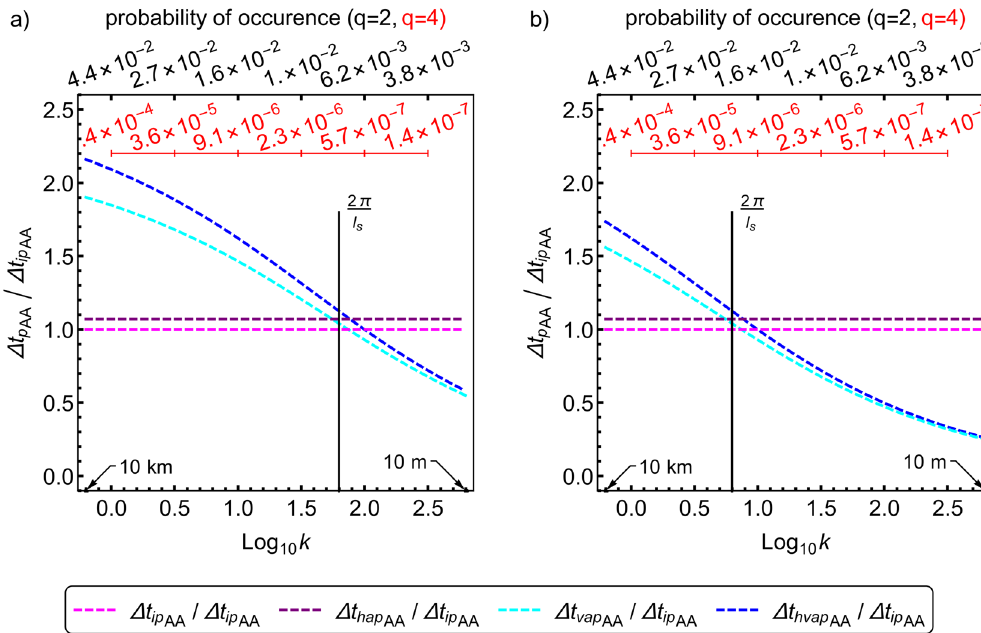
Figure 5. Ratio of the angular averaged theoretical predictability limits of anisotropic horizontal wind fields to that of isotropic horizontal wind fields. The wind fields have multifractal parameters α = . = . = . C H 1 5, 0 15, 0 33, and anisotropy parameters, as discussed in the text. The two panels differ only 1 by the sphero-scale l s . The subscripts ip , hap , vap , hvap denote isotropic, horizontally anisotropic, vertically anisotropic, horizontally and vertically anisotropic cases, whereas the subscript AA indicates angular averaging. The wavenumber k = | k | is in km − 1 and corresponds to scales ranging from 10 m to 10 km. The ratios of the angular averaged predictability limits are independent of the order of statistical moment q and, therefore, of how probable the occurrence of the event is. ( a ) the spatially anisotropic fields have l s = 100 m . ( b ) same as a, but the spatially anisotropic fields have l s = 1000 m . The probability of occurrence values in Fig. ( a,b ) are the same as those in Figs. 3 and 4. Vertical stratification enhances and diminishes predictability in the subsphero and supersphero-wavenumbers. Horizontal stratification improves predictability over all scales. Wind fields with smaller spheroscales are better predictable. Larger events are more probable and have larger anisotropic to isotropic angular averaged predictability limit